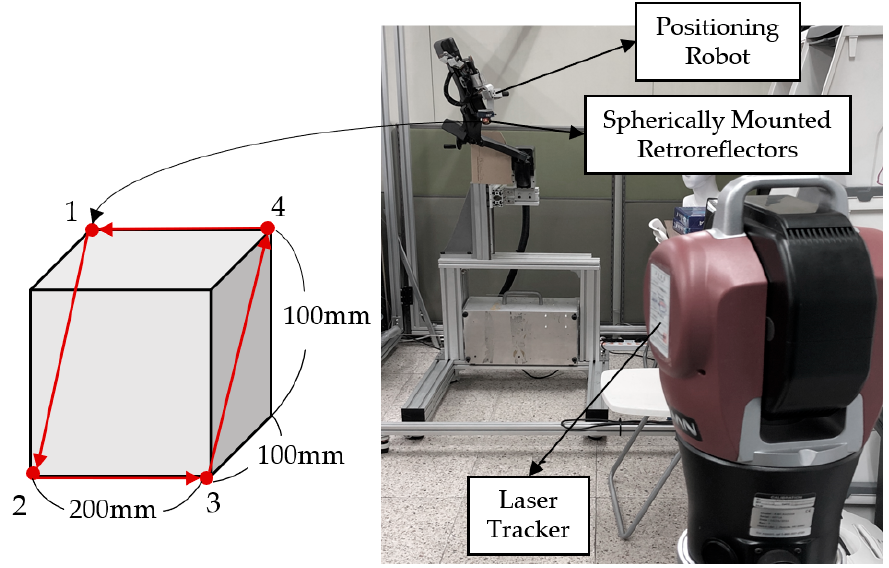
Figure 8. Setup of repeatability test of robot and test geometry.